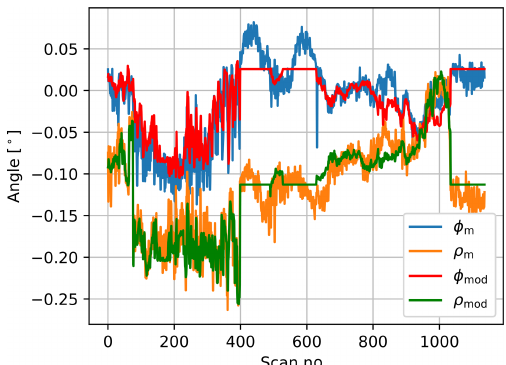
Figure 15. Comparison of the roll ρ m and pitch φ m angles mea- sured by the SSL and the roll ρ mod and pitch φ mod angles modelled by the PTM.